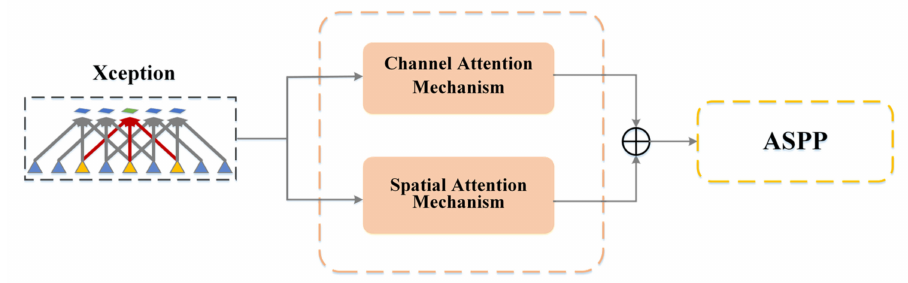
Figure 3. The DAM module structure diagram of the improved DeepLab V3+